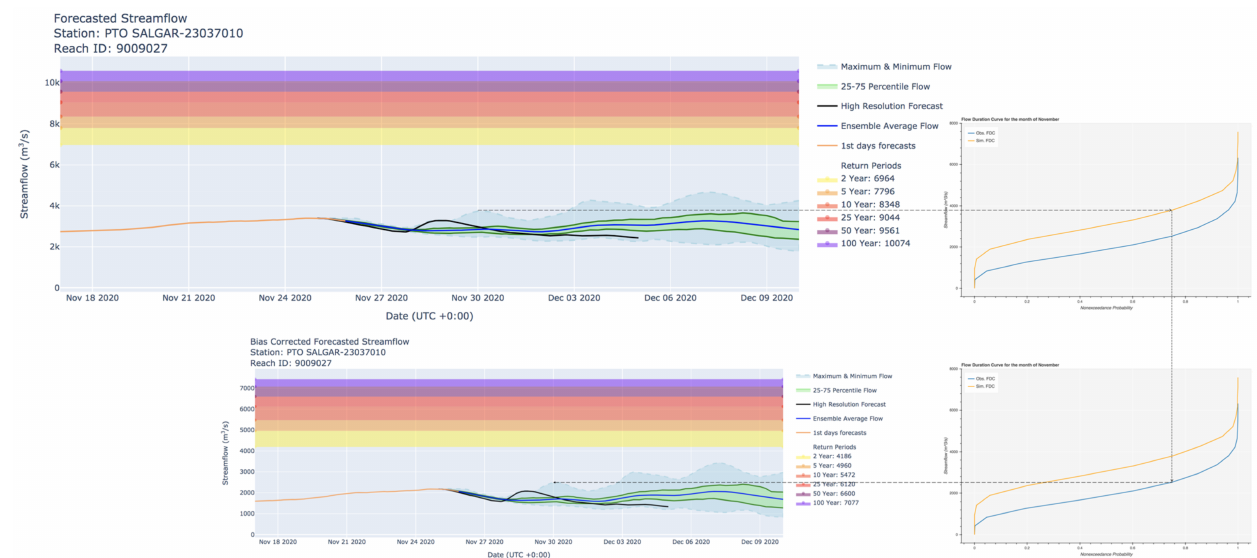
Figure 4. Plots showing data corrected using the correction methodology we developed for the GESS